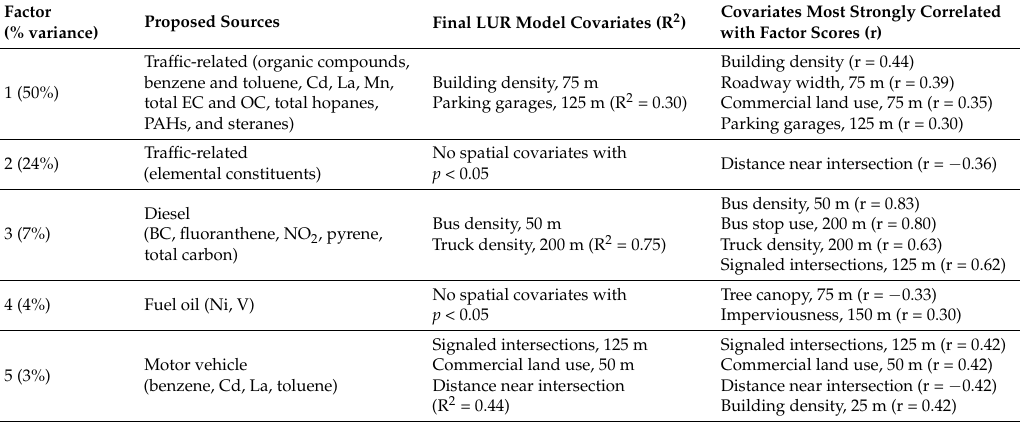
Table 2. Winter factor score LUR (land use regression) results ( n = 36). Percentage of explained variance is listed under each factor, along with proposed sources, final LUR covariates (with final R 2 ), and covariates most strongly correlated with factor scores